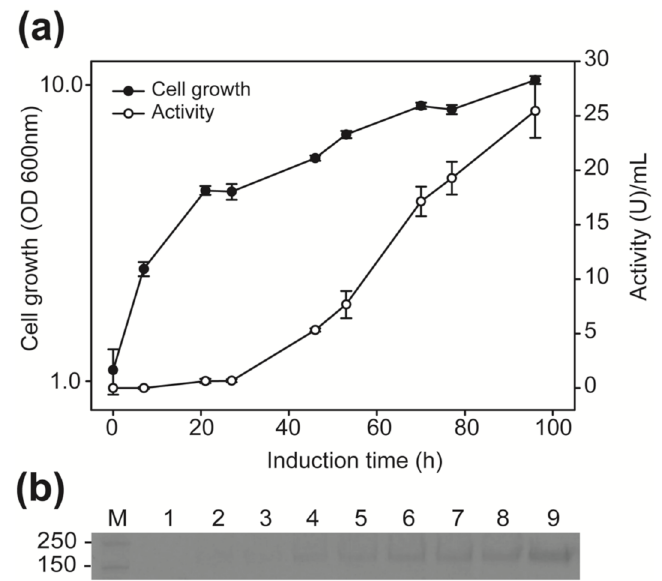
Figure 2. Time course of the β -fructofuranosidase produced in P. pastoris, including construction cRdINV-pIB4. ( a ) Yeast was cultured in 1-L flasks containing 200 mL of BMM (full circles), and extracellular activity (empty circles) was analyzed at the indicated times using sucrose as substrate. Each point represents the average of three independent measurements, and standard error are indicated. ( b ) Analysis on SDS-PAGE of the ~170 kDa protein detected at the times culture above was analyzed (lanes 1–9: 0, 7, 21, 27, 46, 53, 70, 77 and 96 h, respectively). Numbers on the left indicate the positions of molecular mass standards (lane M) in kDa.